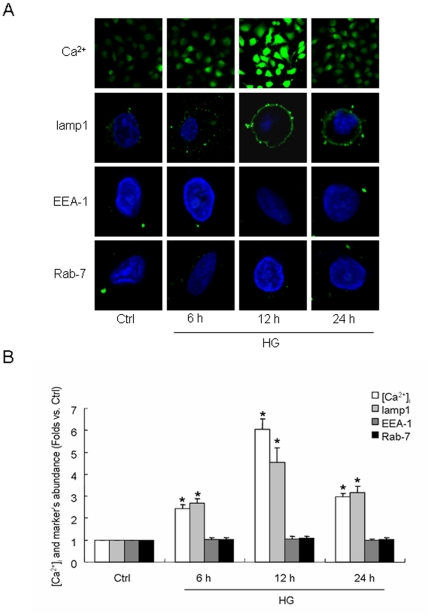
Lysosomal moving to cellular membrane promoted by hyperglycemia.A: representative images of intracellular free Ca2+ concentration ([Ca2+]i) and presentation of lamp1, EEA-1 and Rab-7, the marker of lysosome, early endosome and late endosome respectively, on membrane of human umbilical vein endothelial cells (HUVEC) stimulated by normal glucose (5.6 mmol/l, Ctrl) or high glucose (22 mmol/l, HG) for 6 h, 12 h and 24 h. B: summarized data of [Ca2+]i and fluorescent abundance of lamp1, EEA-1 or Rab-7 on cellular membrane in different groups. Values are means±SE; n = 5 batches of cells. * P<0.05 vs. Ctrl.